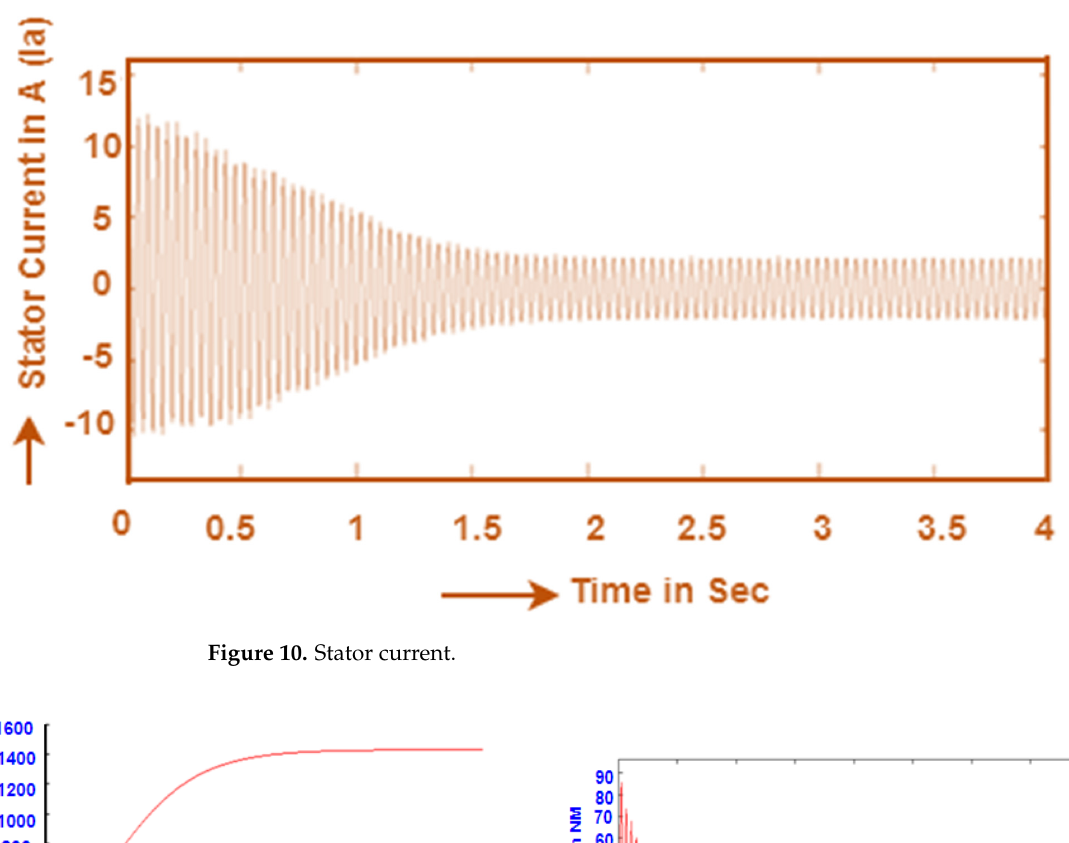
Figure 10. Stator current.